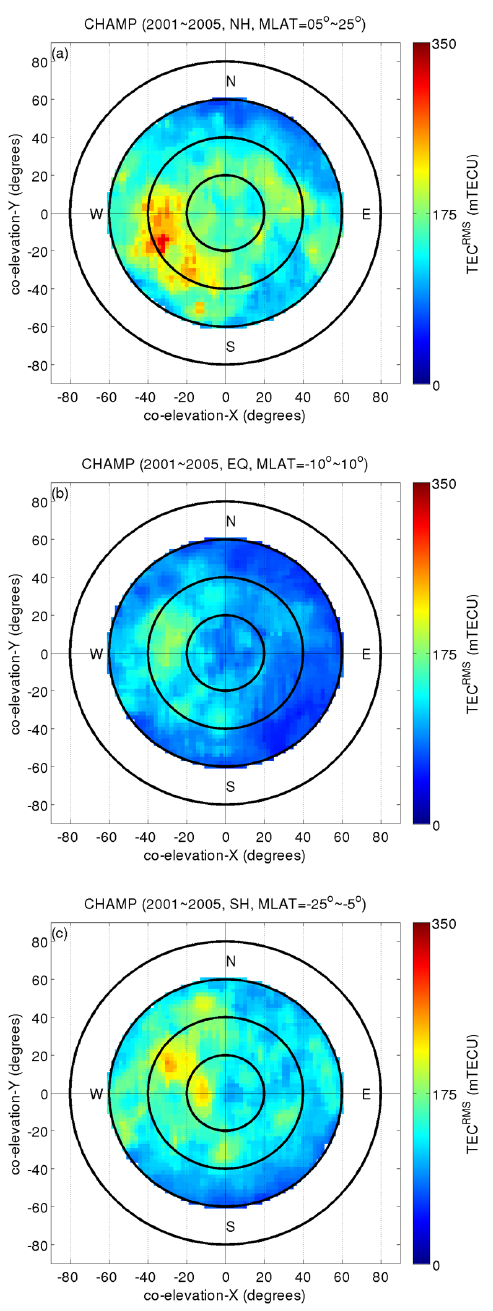
Figure 3. Polar plots showing TEC fluctuation level as a func- tion of co-elevation and azimuth angles of GNSS satellites as seen from CHAMP: (a) northern low-latitude region (between + 5 and + 25 ◦ N), (b) equatorial region (between − 10 and + 10 ◦ N) and (c) southern low-latitude region (between − 25 and − 5 ◦ N). Note that only the TEC values are used which were obtained near in situ EPB encounters (judged by the CHAMP/PLP data fluctuation as shown in Fig.